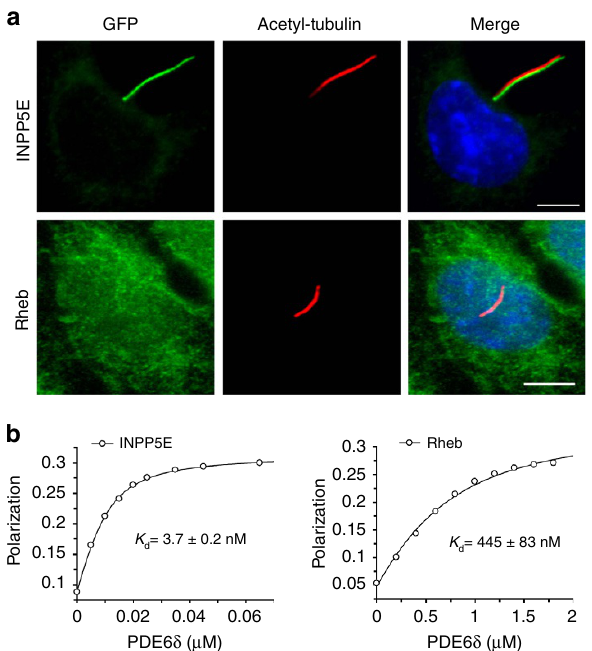
Figure 1 | Localization of INPP5E and Rheb and their affinity to PDE6 d . ( a ) Localization of INPP5E and Rheb in IMCD3 cells. Stably expressed GFP- INPP5E colocalizes with acetylated tubulin, as shown by immunostaining of acetylated tubulin (red) and GFP fluorescence (LAP-tagged) (green), while GFP-Rheb (green) localizes to endomembranes and is almost absent from cilia. White bar indicates 5 m m. ( b ) 0.01 m M TAMRA-labelled farnesylated peptide (SQNSSTIC(Far)-OMe) from INPP5E (left) and 0.5 m M FITC- labelled peptide (SQGKSSC(Far)-OMe) from Rheb (right) were titrated with increasing concentrations of PDE6 d and the increase in fluorescence polarization was plotted against the PDE6 d concentration. The data were fitted to a quadratic equation giving the indicated dissociation constants ( K d ). ± indicates s.d. ( n Z 9). (Fig. 2b). To compare the cargo release kinetics of Arl2 (cid:3) GppNHp and Arl3 (cid:3) GppNHp, we measured the dissociation rate constants of INPP5E and Rheb peptides from PDE6 d in the presence and absence of Arl3 (cid:3) GppNHp or Arl2 (cid:3) GppNHp, by adding a large excess of unlabelled peptide to silence the back reaction. In the absence of Arl2/3, Rheb showed an intrinsic dissociation rate ( k off ¼ 0.95 ± 0.004 s (cid:2) 1 , ± indicates s.d., n ¼ 4), while no measurable dissociation rate could be observed for INPP5E in a reasonable time window. This observation is in line with the almost 100-fold difference in the binding affinity between both peptides determined from the steady state equilibrium measurements. The presence of Arl3 (cid:3) GppNHp or Arl2 (cid:3) GppNHp has a similar acceleration effect on the dissociation rate of Rheb peptide from PDE6 d ( k off ¼ 27.2 ± 0.7 and 15.3 ± 0.3 s (cid:2) 1 , respectively, ± indicates s.d., n ¼ 4) (Fig. 2c,d). However, the release of INPP5E peptide in the presence of Arl3 (cid:3) GppNHp shows an estimated 10,000-fold acceleration ( k off ¼ 10.7 ± 0.2 s (cid:2) 1 , ± indicates s.d., n ¼ 4), while release by Arl2 (cid:3) GppNHp ( k off ¼ 0.018 ± 0.0005 s (cid:2) 1 , ± indicates s.d., n ¼ 4) is almost 600-fold slower (Fig. 2e,f). Taken together, our data suggest that high-affinity farnesylated cargo can be specifically released by Arl3, while low-affinity cargo can be released similarly by both Arl2 and Arl3. Previously we have shown that the N-terminal helix of Arl3 is NATURE COMMUNICATIONS|7:11366|DOI: